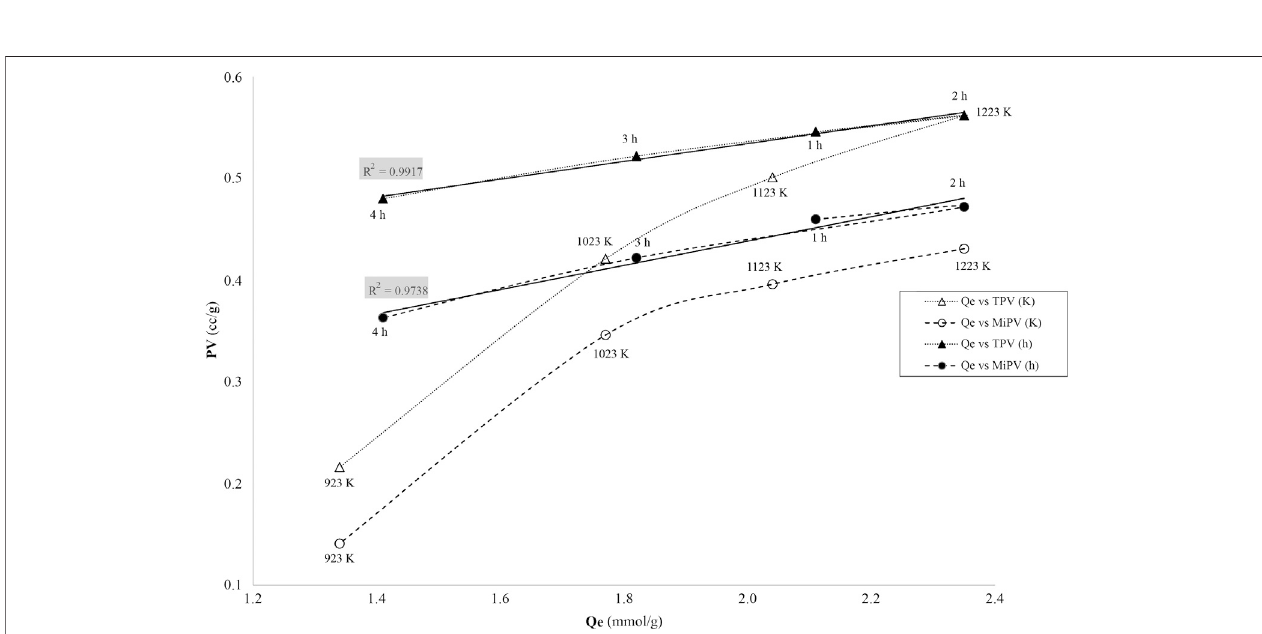
FIGURE 7 | Adsorption curves for MB onto bamboo derived activated carbons produced at four temperatures (N 2 ; 2 h, 355 – 500 μ m).